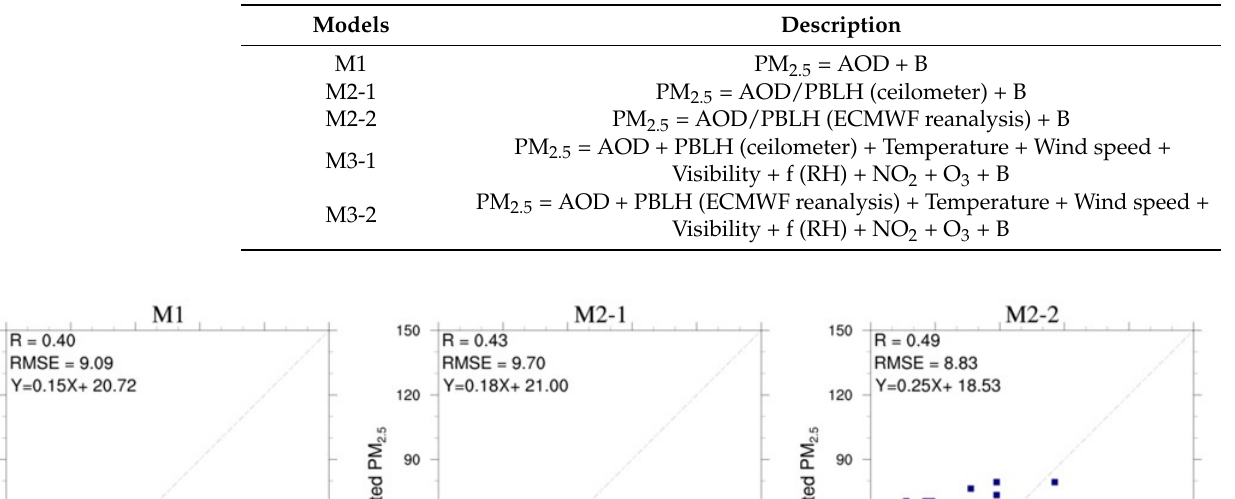
Table 3. Detailed description of statistical models applied in this study for the PM 2.5 estimation using AOD data (PBLH: planetary boundary layer height, RH: relative humidity, and B: intercept value. F(RH) is equal to 1/{1 – (RH / 100)}, referring to Seo et al. (2015) [24]. The units of the data used are as follows: PM 2.5 ( µ g/m 3 ), AOD (unitless), PBLH (km), temperature (K), wind speed (m/s), visibility